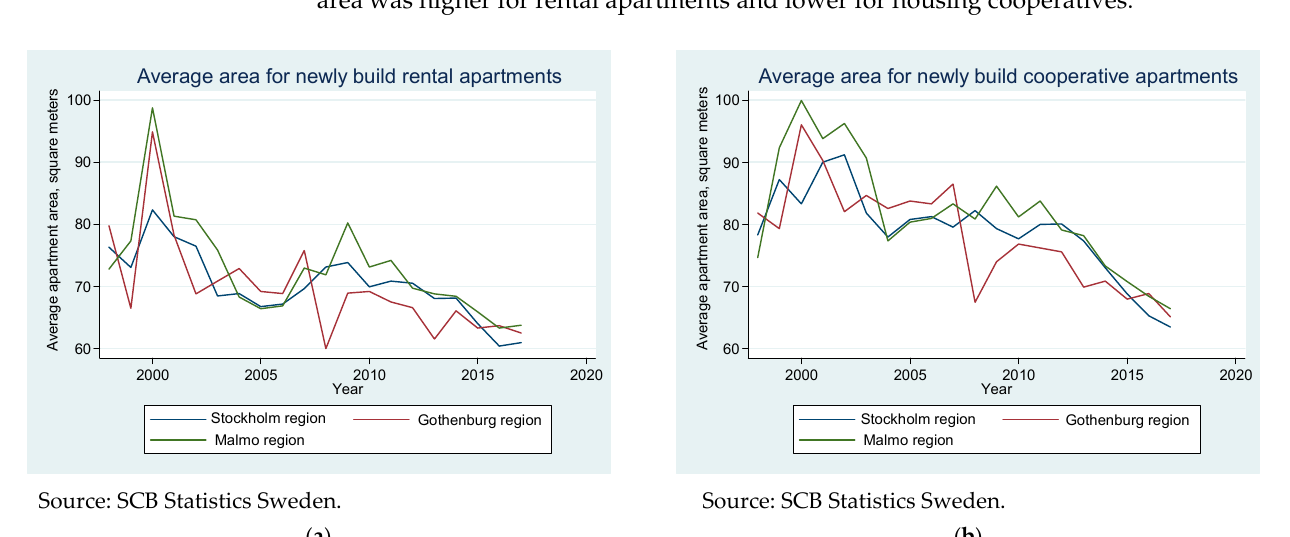
Figure 6. Average apartment area in new multifamily buildings in the three largest urban areas in Sweden: ( a ) in rental apartments; ( b ) in housing cooperative apartments. Figure 7 presents the population dynamics during the study period. The annual population change in major Swedish cities is plus 14,739, which is 1.2 percent growth in the average population within these areas.